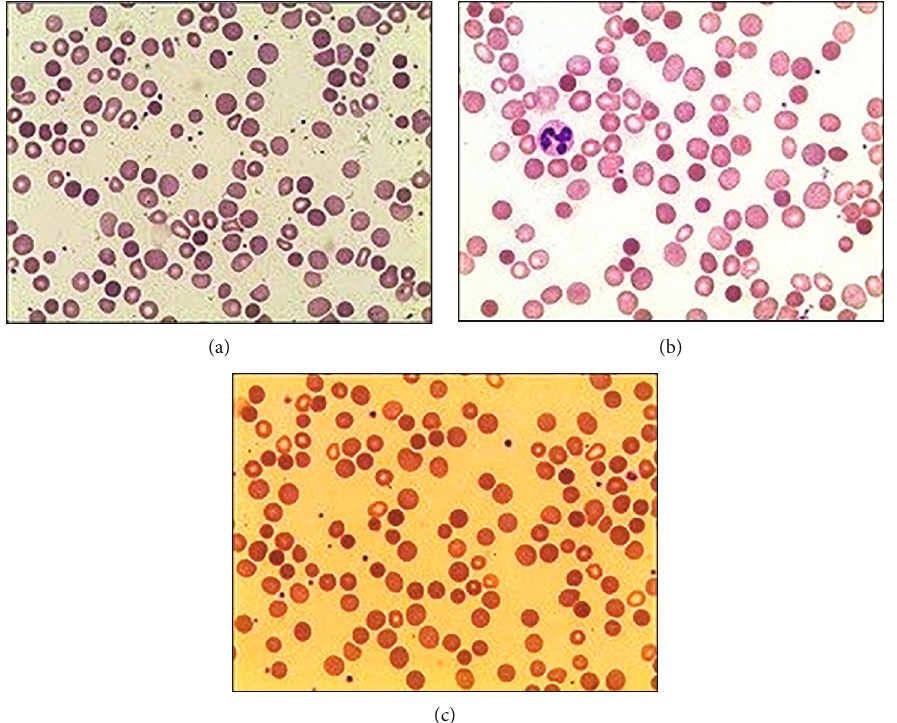
Figure 1: Peripheral blood smear, from top to bottom, I-1, II-1, and III-1,